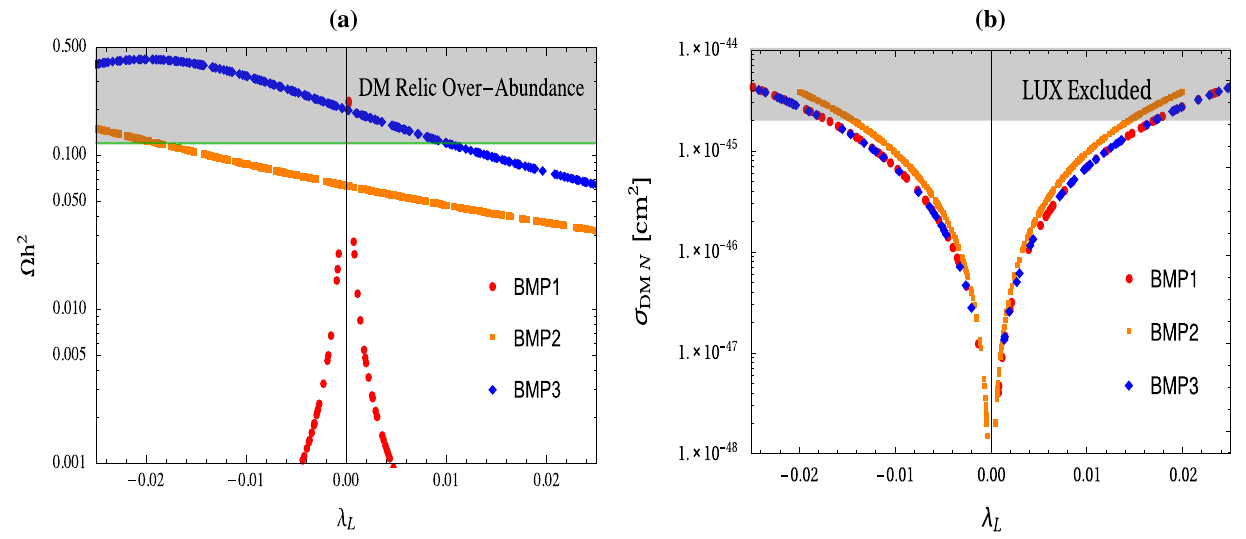
Fig. 2 a Abundance of IDM dark matter as a function of parameter λ L . b Limits on the dark matter-nucleon cross section as a function of λ